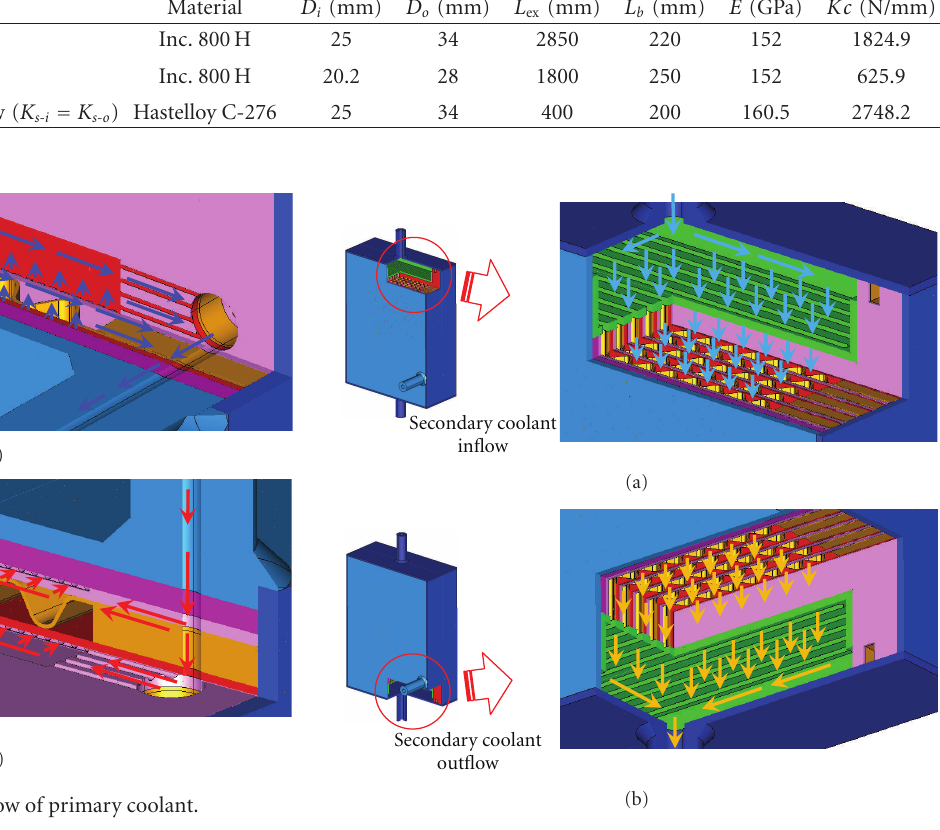
Figure 8: Inflow/outflow of secondary